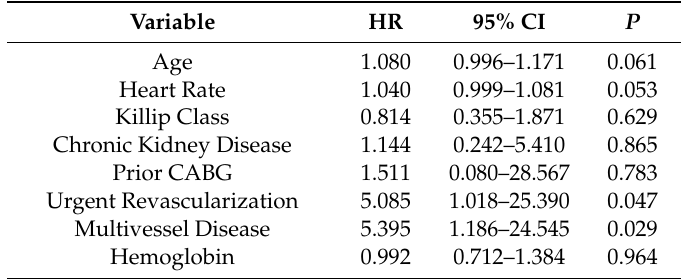
Table 4. Multiple regression analyses for predicting all-cause mortality in the Type 2 MI Group.